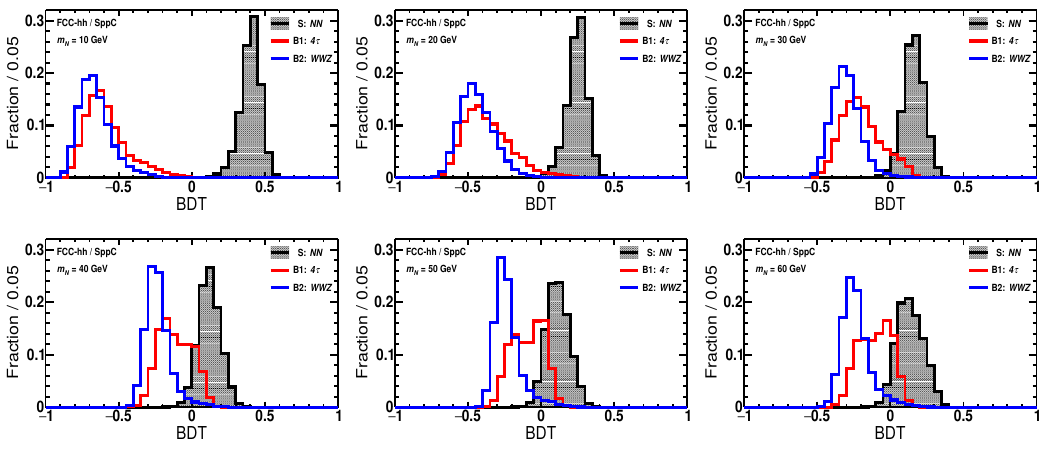
Figure 7 . The BDT distributions of the same processes as in (cid:12)gure 6, but at the FCC-hh/SppC.